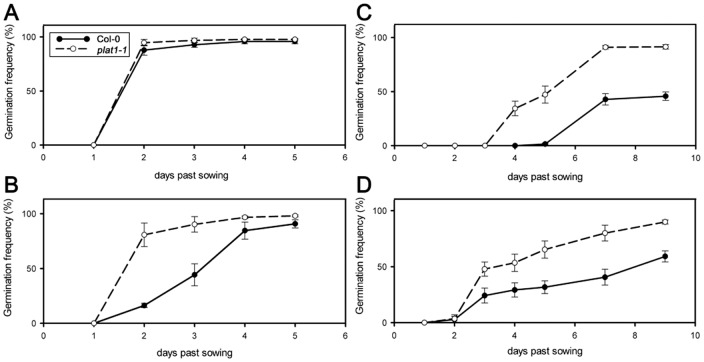
PLAT1 loss-of-function reduces ABA sensitivity during seed germination.(A) Seed germination of plat1-1 and wild-type (Col-0). (B) Seed germination of plat1-1 and wild-type on 300 mM mannitol (osmotic stress). (C) Seed germination of plat1-1 and wild-type on 200 mM NaCl (salt stress). (D) Seed germination of plat1-1 and wild-type on 1.5 µM ABA. Values are means of 3 replicates ± standard deviation. n≥100 per replicate.